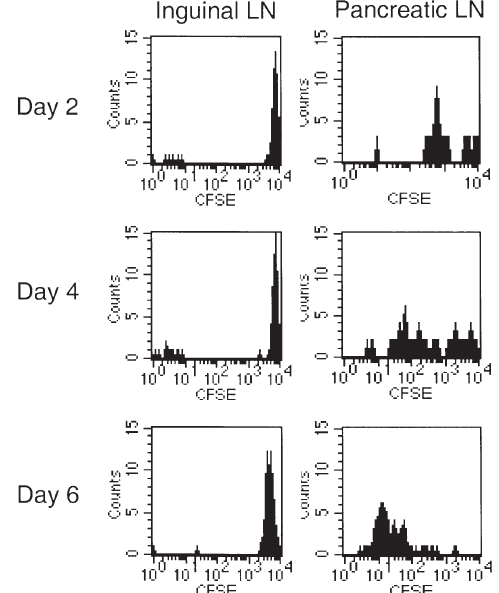
FIGURE 3 Transferred 3A9 T cells proliferate in the pancreatic lymph node of RIP-HEL recipients. 2.5million naı¨ve 1G12 þ T cells were CFSE labeled and adoptively transferred into RIP-HEL recipients. At the indicated time point post transfer, mice were sacrificed and the pancreatic and inguinal lymph nodes dissected and stained with anti-CD4-PerCP and biotinylated 1G12 followed by streptavidin-PE. Histograms show the CFSE profiles of gated CD4 þ 3A9 þ T